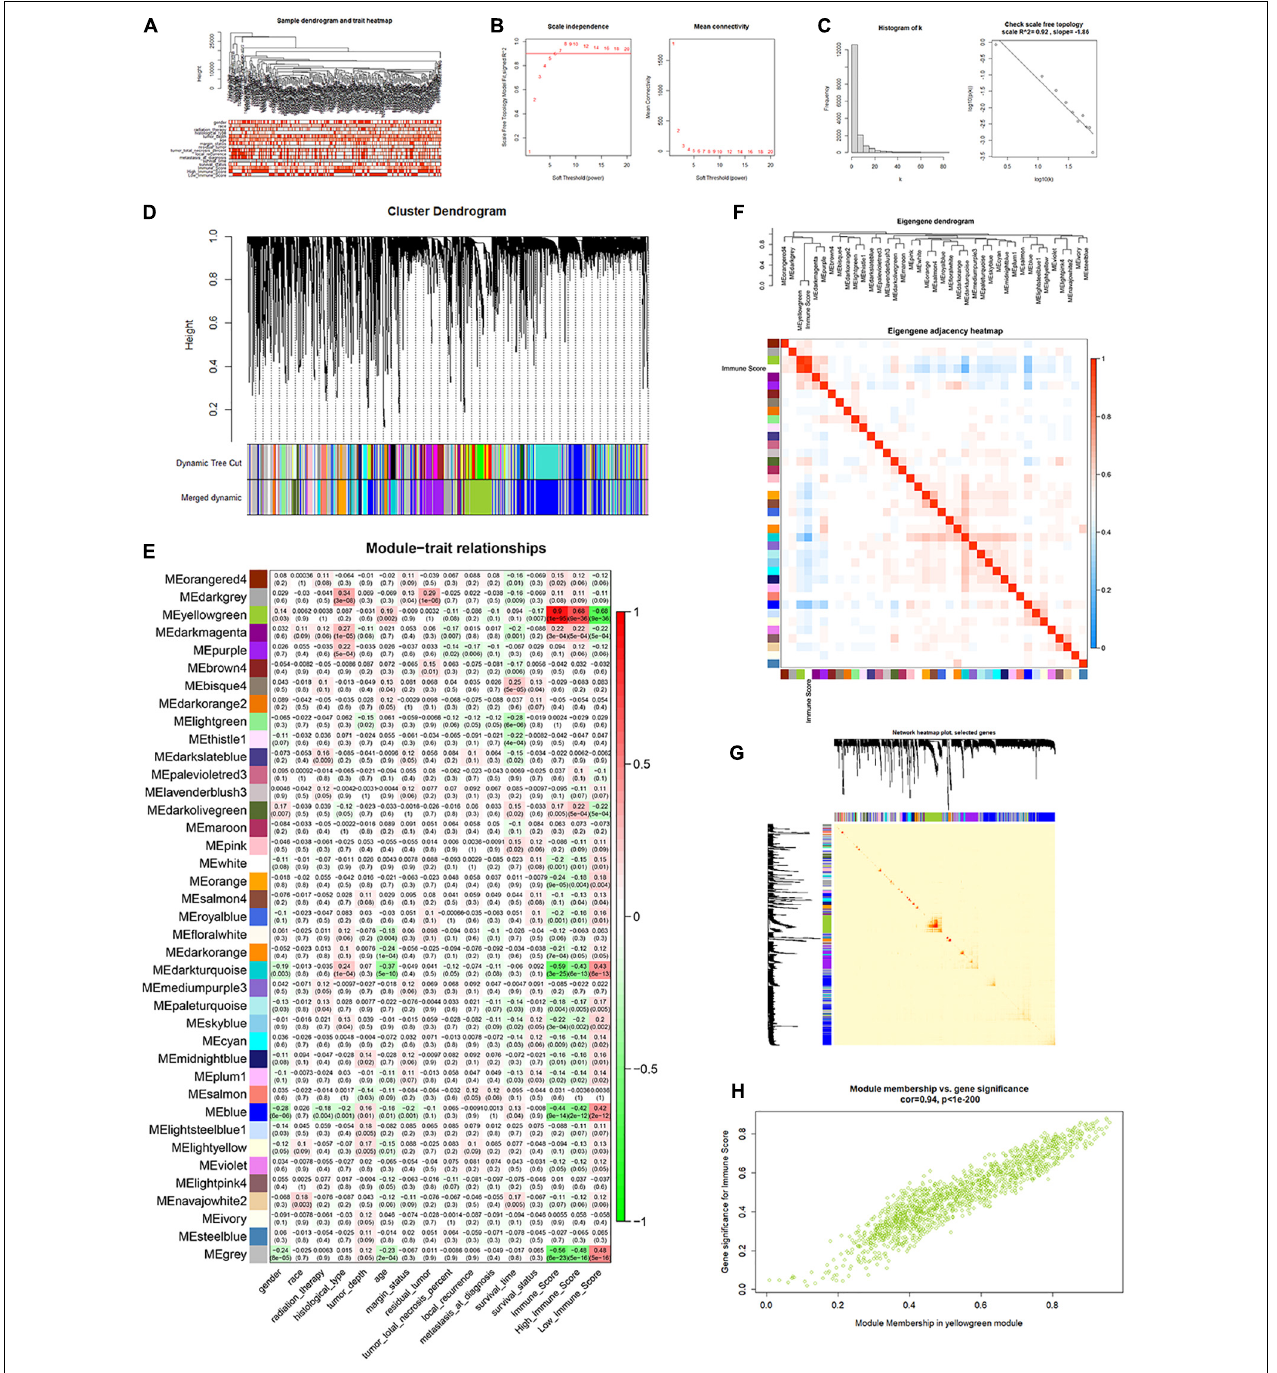
FIGURE 4 | Identification of immune score-related gene clusters by WGCNA. (A) Sample dendrogram and trait heatmap. (B,C) Calculation and evaluation of the best β value in the co-expression network. (D) Merged dynamic gene cluster dendrogram. (E) Analysis and visualization of the module–trait relationship. (F) Eigengene adjacency heatmap with immune score included. (G) The topological overlap measure (TOM) for gene network connections (randomly selected 1,000 genes). (H) Correlation between gene module membership and gene significance for immune score in the yellow-green module (correlation coefficient = 0.94, P < 0.0001).